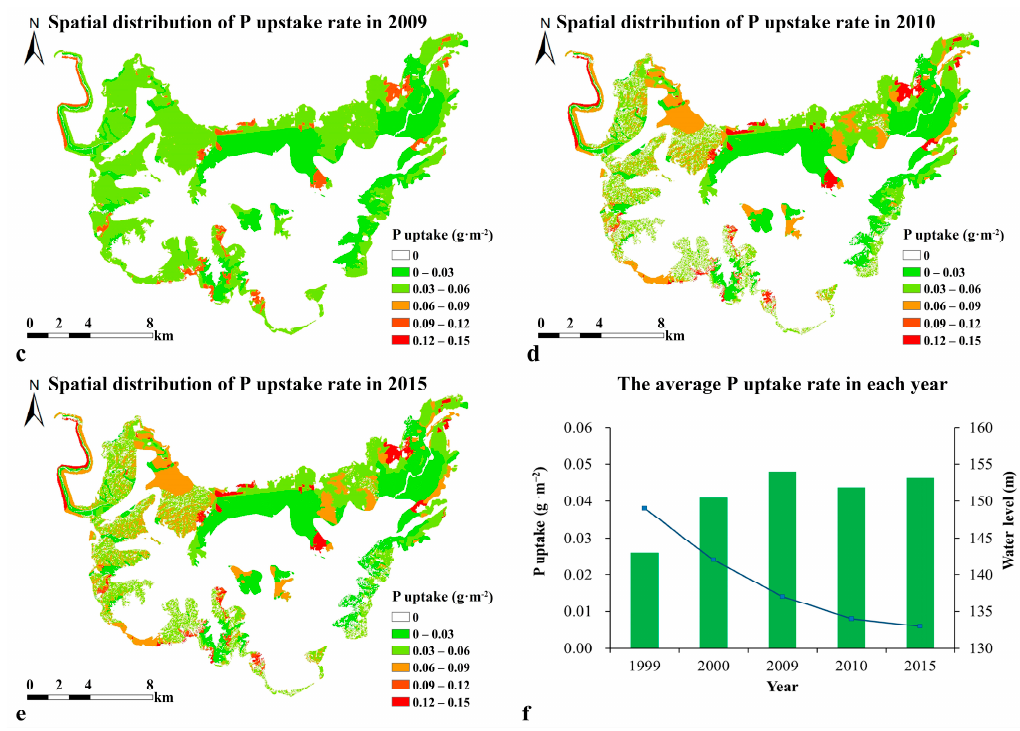
Figure 6. Spatial distribution of the P uptake rate in Miyun’s inner protection zone during different years.